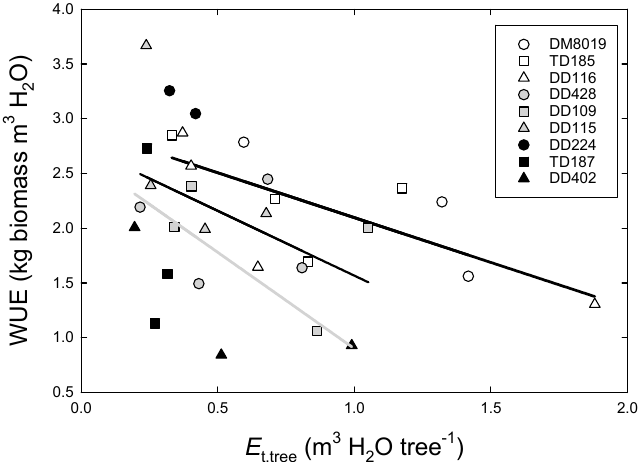
Figure 5. Relationship between water use efficiency of production (WUEp) and total tree water use ( E t,tree , m 3 H 2 O tree − 1 ) over the 146 day study period in P. deltoides (DD), P. trichocarpa × deltoides (TD), and P. deltoides × maximowiczii (DM) clones. Open, light shaded, and dark shaded symbols, and heavy black, light black, and grey lines represent high (Group H), intermediate (Group I), and low (Group L) productivity genotypes, respectively.